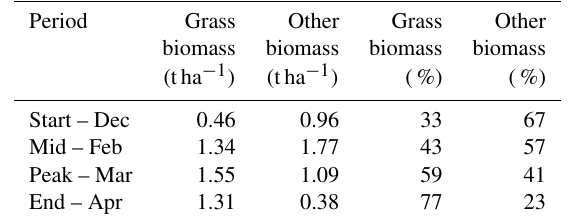
Table 1. Understory biomass harvest information for Howard Springs savanna collected across the wet seasons from 2012 to 2014. Period Grass Other Grass